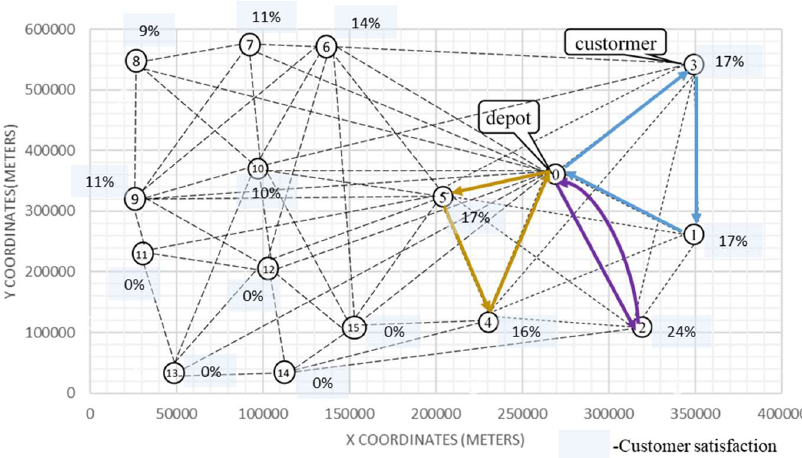
Figure 19. Obtained flight-mission plan for the second FTW.